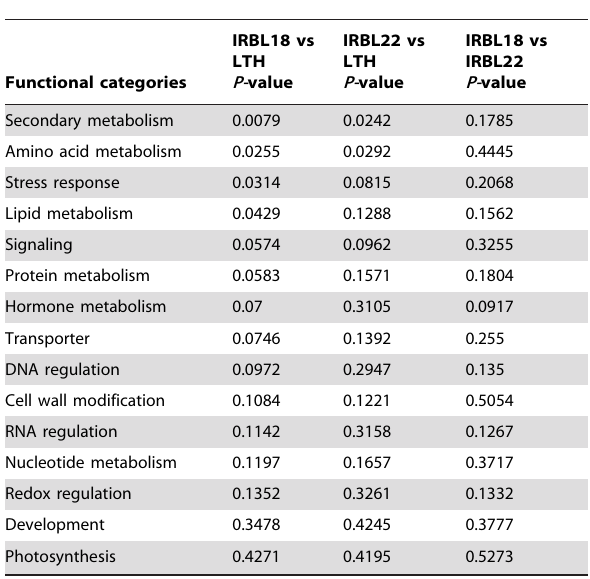
Table 4. The result of Gene-set enrichment analysis on functional categories.